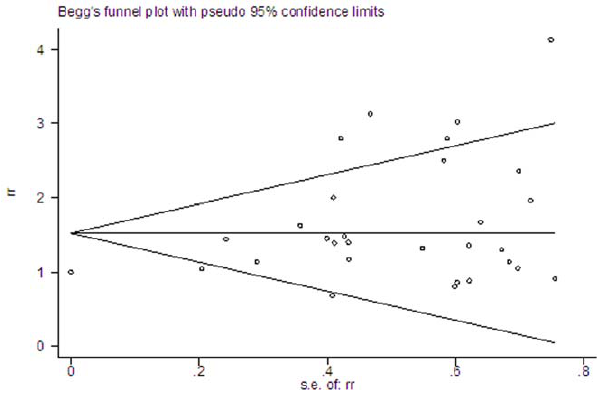
Figure 1. Nonlinear dose-response analyses of body mass index and relative risk of liver cancer in meta-analysis. ( P - heterogeneity=0.001; P -non-linear , 0.001).